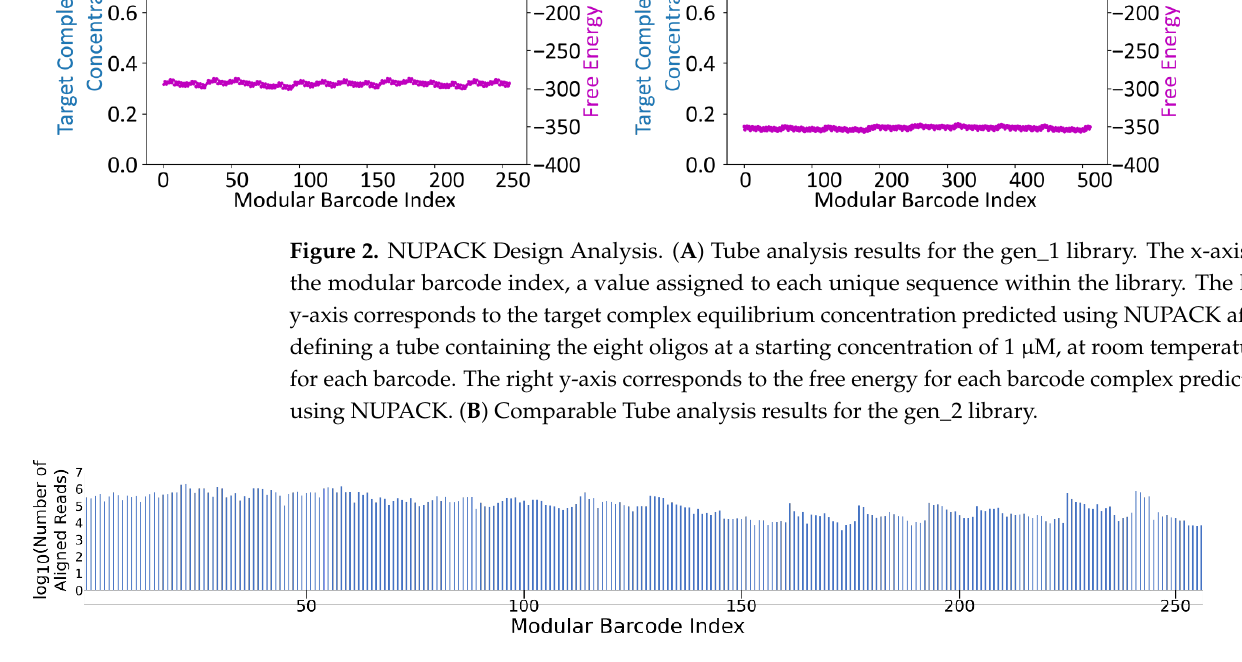
Figure 3. Gen_1 NGS recovery of all 256 modular barcodes. Here, ~80 M joined reads were aligned and assigned using a custom Python script. All barcodes were detected at read quantities ranging from 10 3 to 10 6 , validating the multiplexing capability provided by the modular barcode design. Table 3. Barcode recovery by library for 1 M read